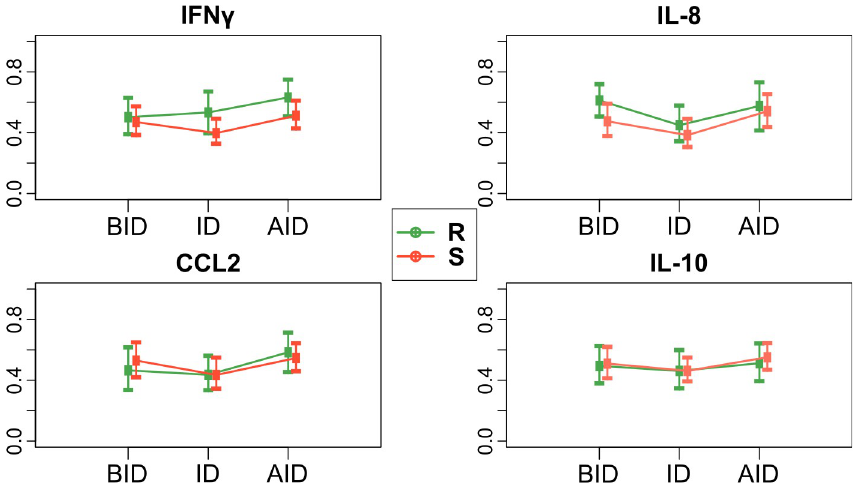
Fig 3. IFN γ , IL-8, CCL2, and IL-10 relative treatment effects (RTE) of CVL-Resistant (R) and susceptible (S) dogs during follow-up. BID: Before Infection diagnosis, ID: Infection Diagnosis, AID: After Infection Diagnosis. RTE are displayed with corresponding 95% confidence